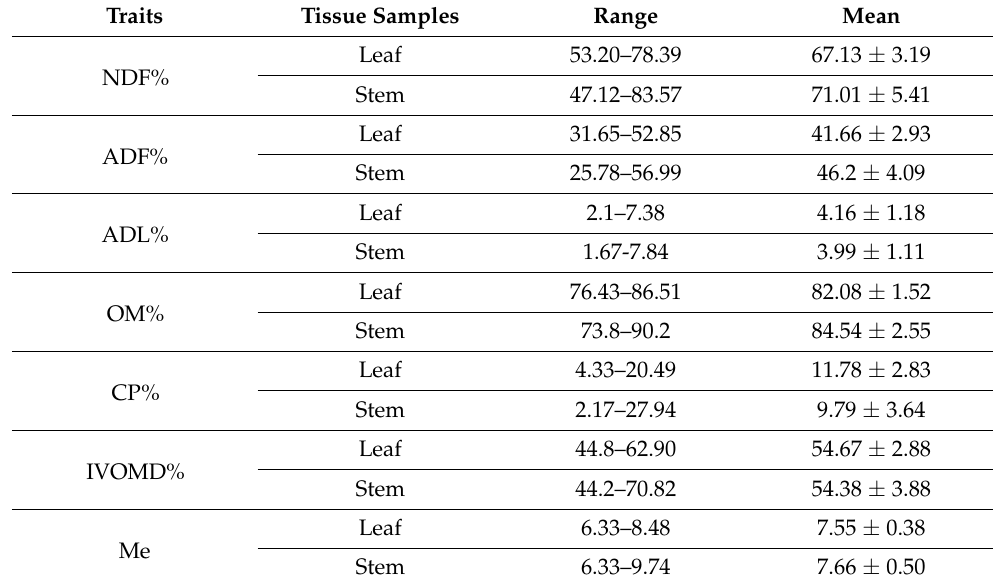
Table A8. Mean and ranges of leaf and stem samples for seven feed quality traits of 84 Napier grass accessions grown under rainy seasons (wet) across six